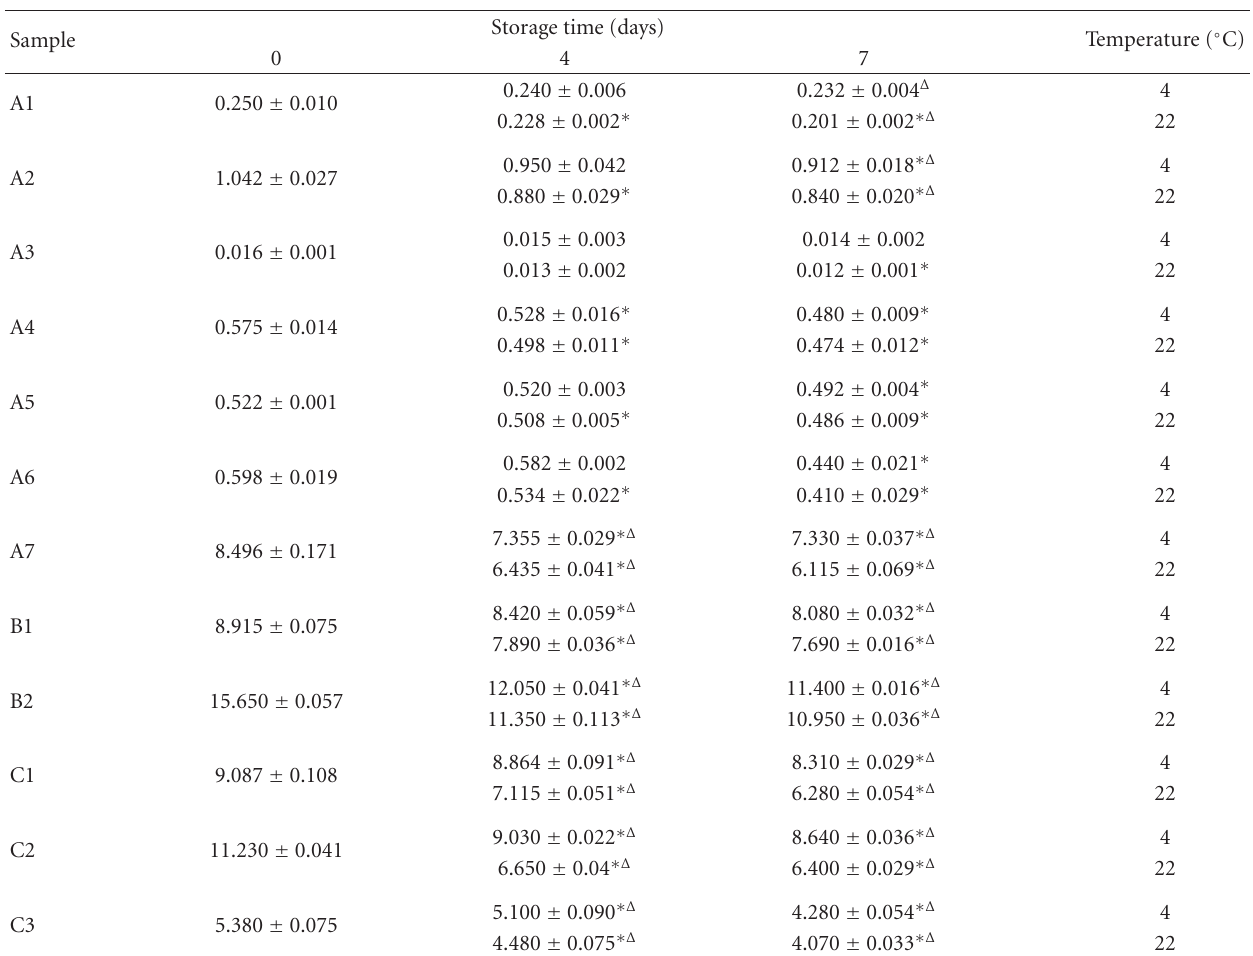
Table 1: Results of ACW determination in individual groups of samples. Mean values are expressed as equivalents of ascorbic acid (mmol/L) when stored at the temperature T = 4 ◦ C and T = 22 ◦ C, and storage time t = 0, 4, and 7 days,